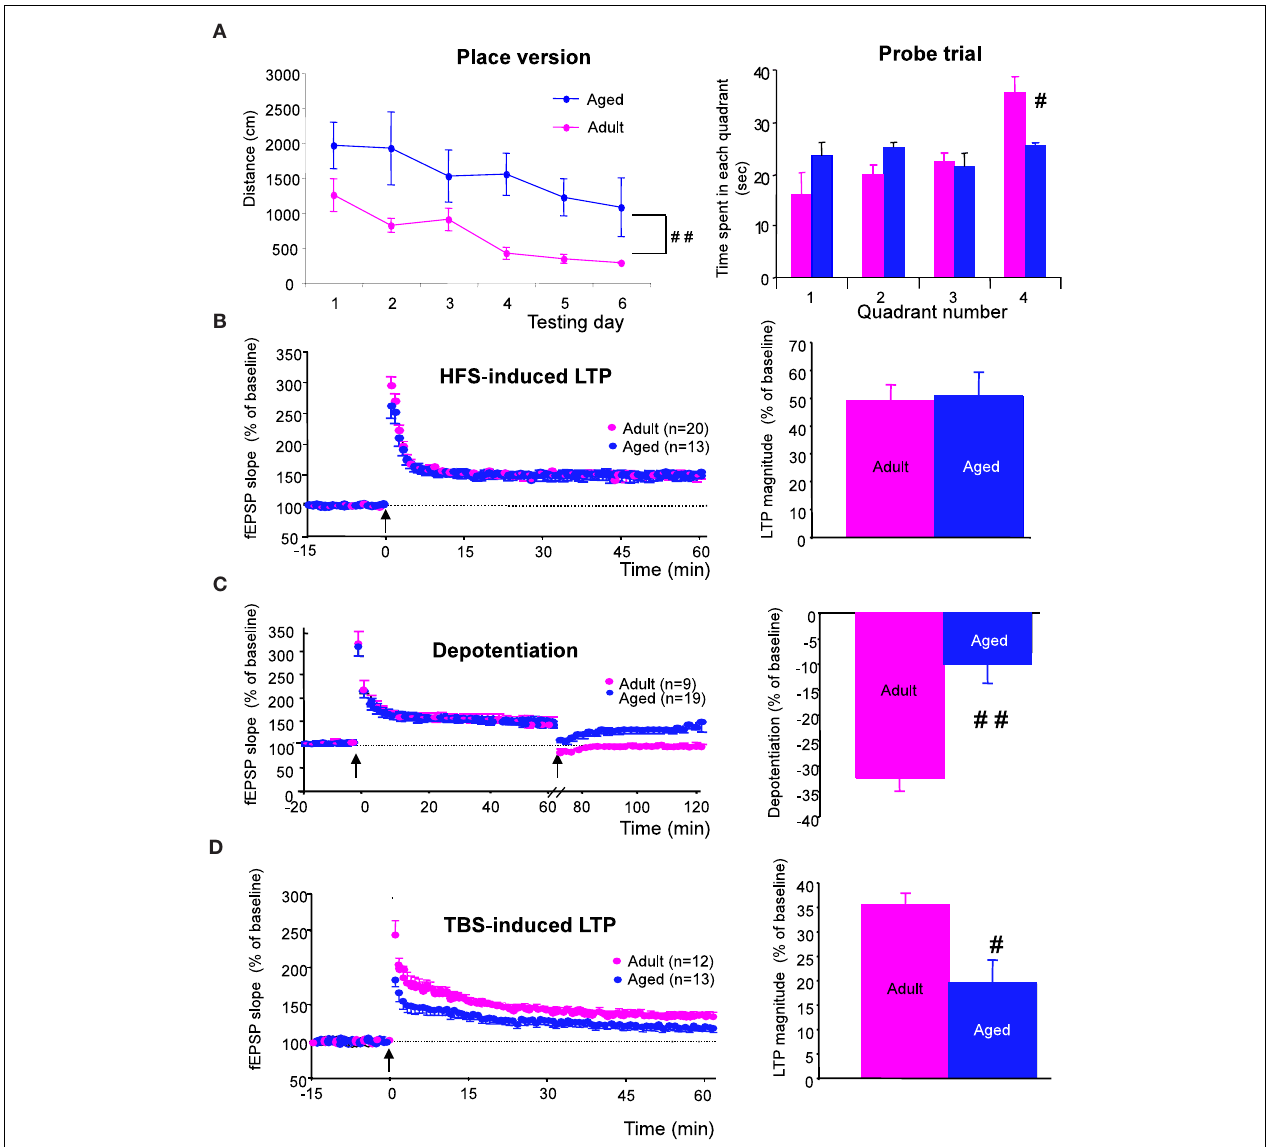
FIGURE 1 | Spatial learning and hippocampal synaptic plasticity are impaired in aged rats. ( A , left) Comparison of the distance swum before escaping onto the hidden platform over 6 days of training in adult and aged rats (## p < 0.01, repeated measures ANOVA). ( A , right) Comparison of time spent by rats swimming through the different quadrants, including quadrant 4, where the platform was situated during place learning, registered over a 90-s probe trial (# p < 0.05, unpaired t -test). ( B , left) Time-course of LTP